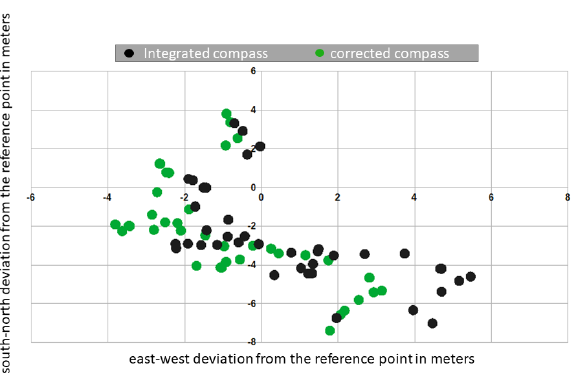
Figure 9. Site: 3, Direction: 2, Distance: 5m, Device: Samsung S10e